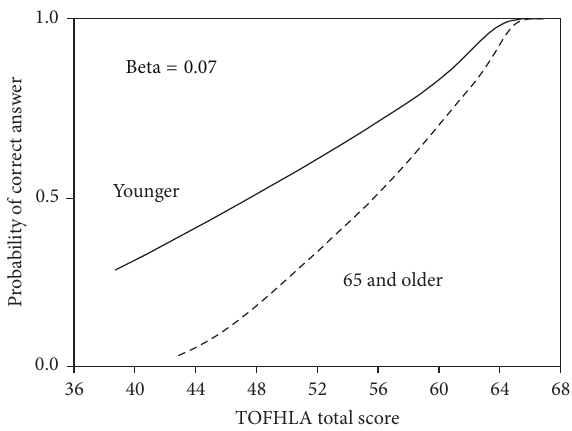
Figure 2: Item response curve for TOFHLA item 41 illustrating DIF between younger and older